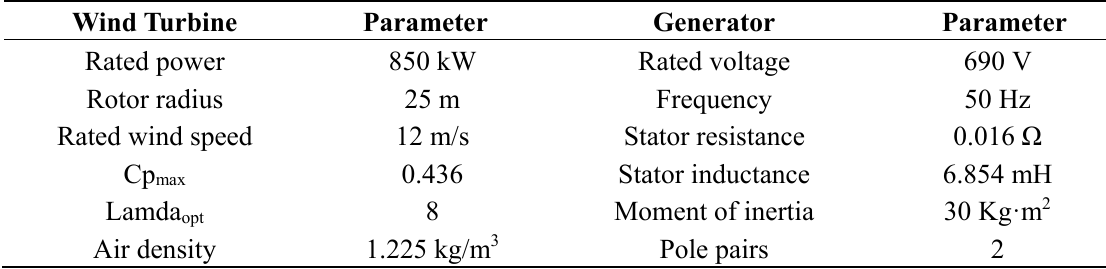
Table 1. Wind turbine